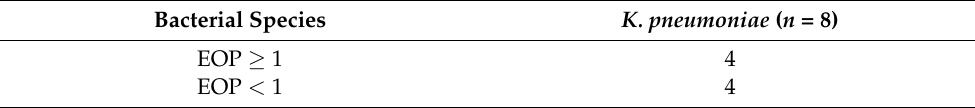
Table 2. EOP for phage ZCKP8 against K. pneumoniae